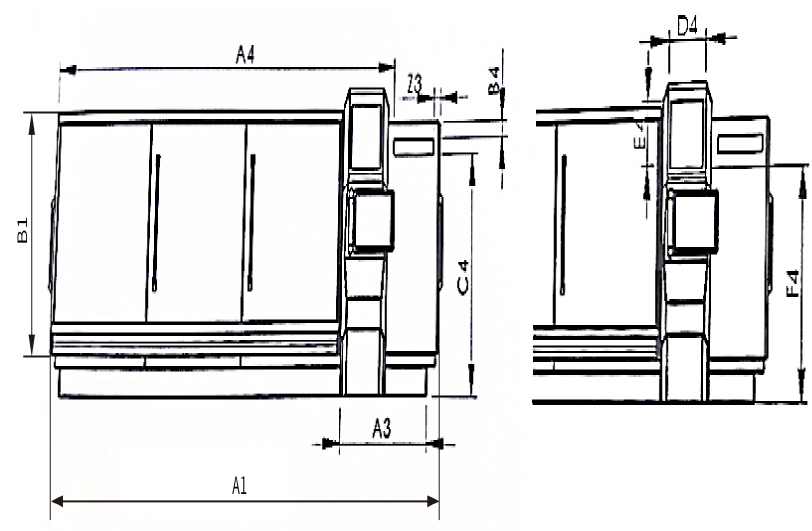
Figure 6. Dimensions and location annotations of the logo and machine tool model. Table 4. The modelling scale specification of the logo and machine tool model.